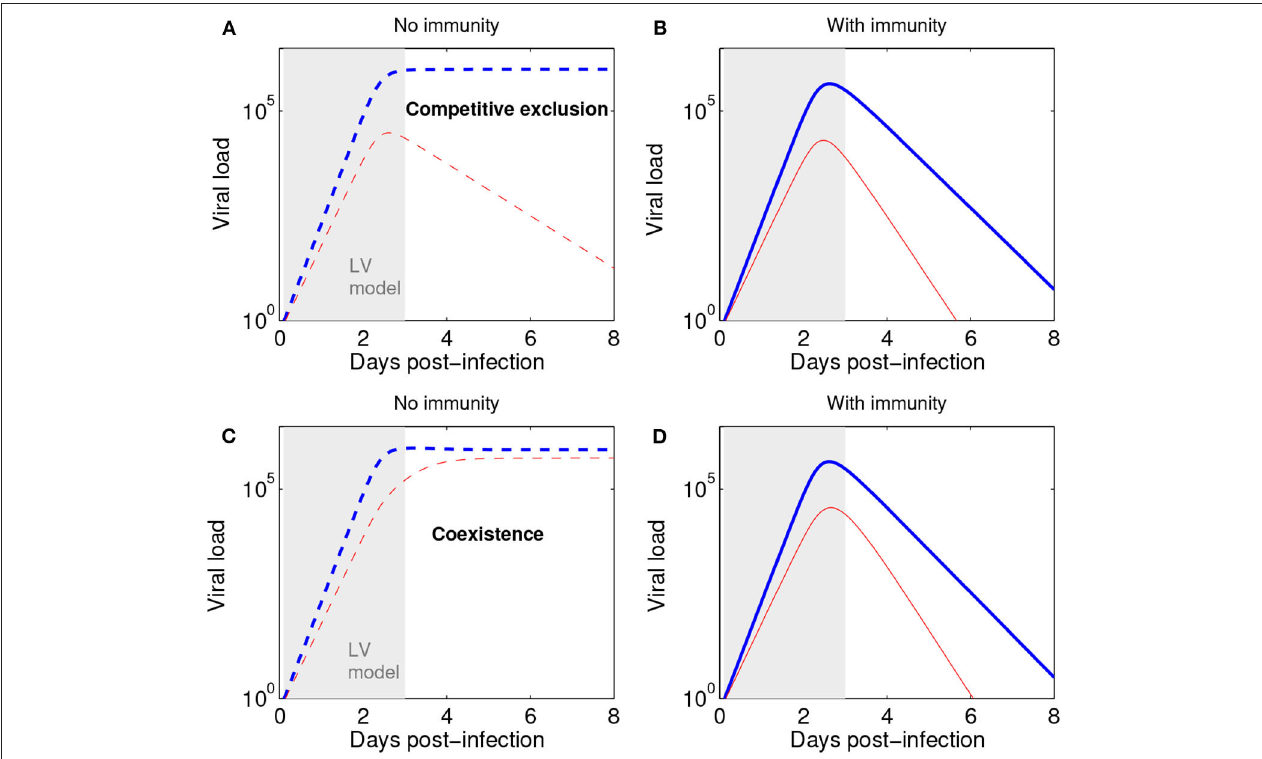
FIGURE 5 | The Lotka-Volterra model can be augmented with action of the immune response to capture later infection stages. (A) Scenario of competitive exclusion (Equations 2–3 in this paper). Parameters, chosen to represent a realistic influenza infection kinetics (e.g., Farrukee et al., 2018; Smith et al.,